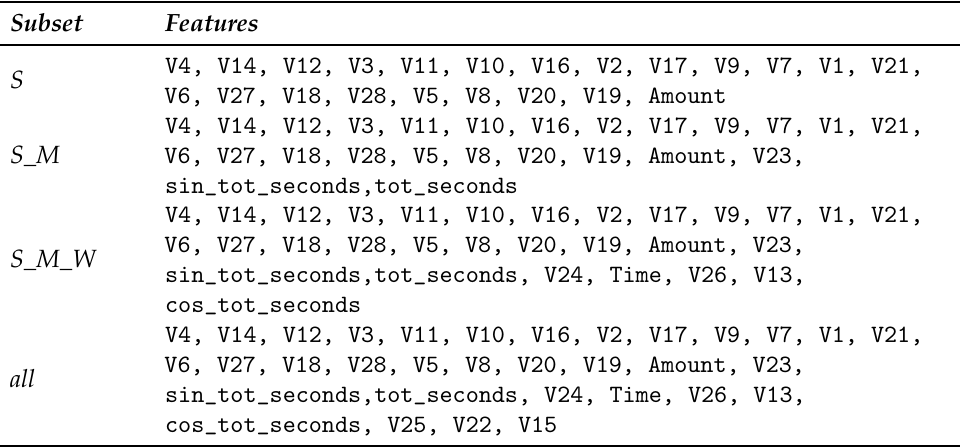
Table 10. CreditCard fraud detection testing subsets.